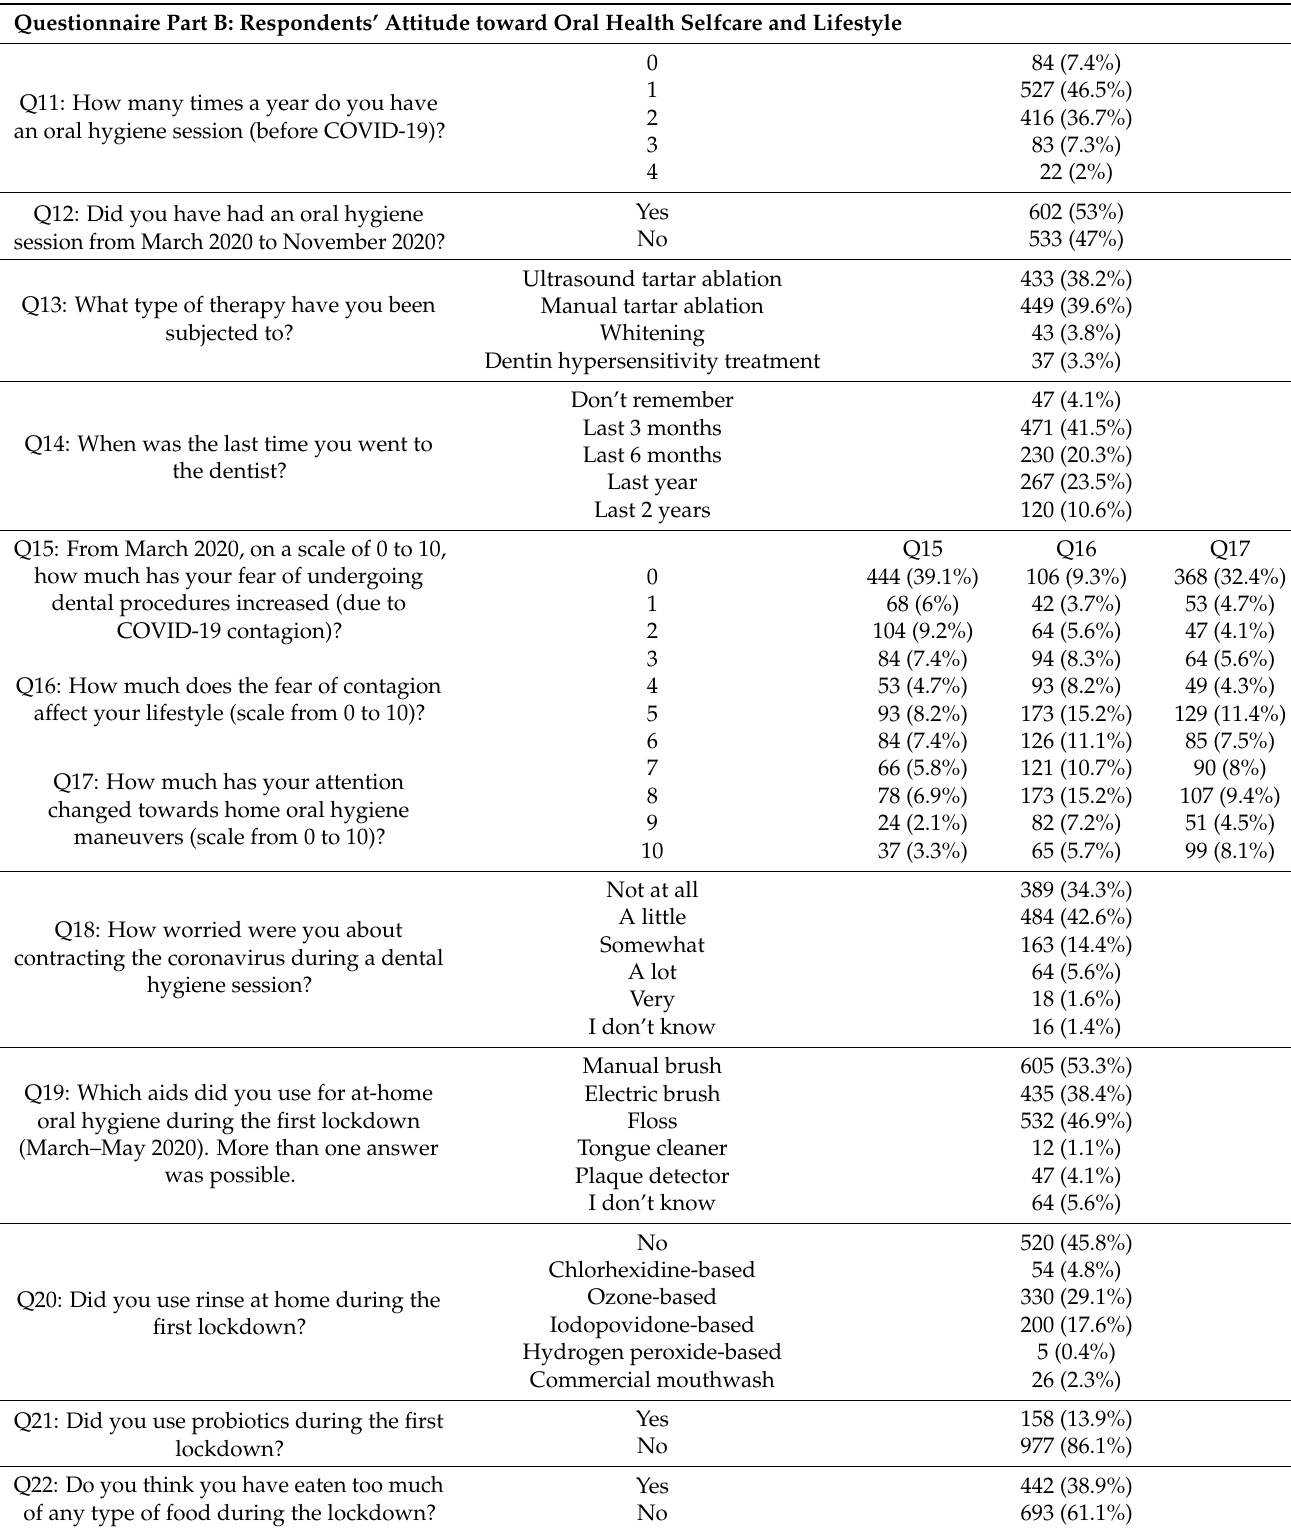
Table 2. Questionnaire Part B—respondents’ attitude toward oral health selfcare and